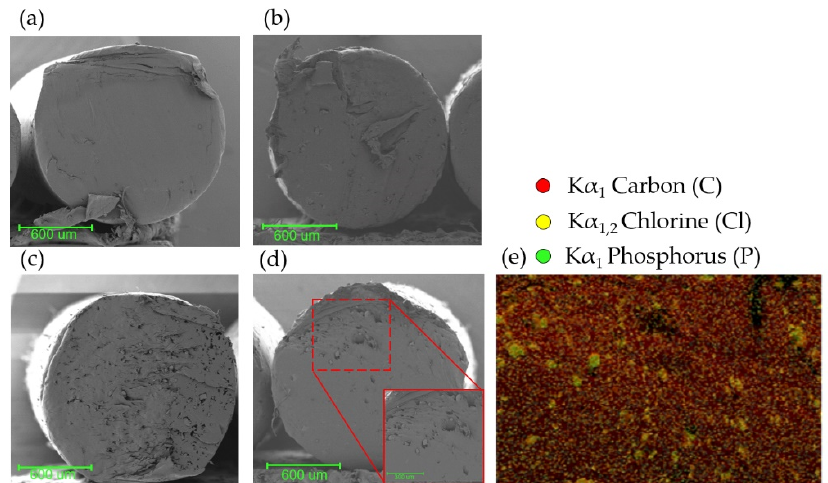
Figure 5. FE-SEM analysis of the filaments ( a ) native PCL; ( b ) PCL/NaCl; ( c ) PCL/nHA; ( d ) PCL/nHA/ NaCl; and ( e ) EDX elemental distribution maps of the PCL/nHA/NaCl filament.